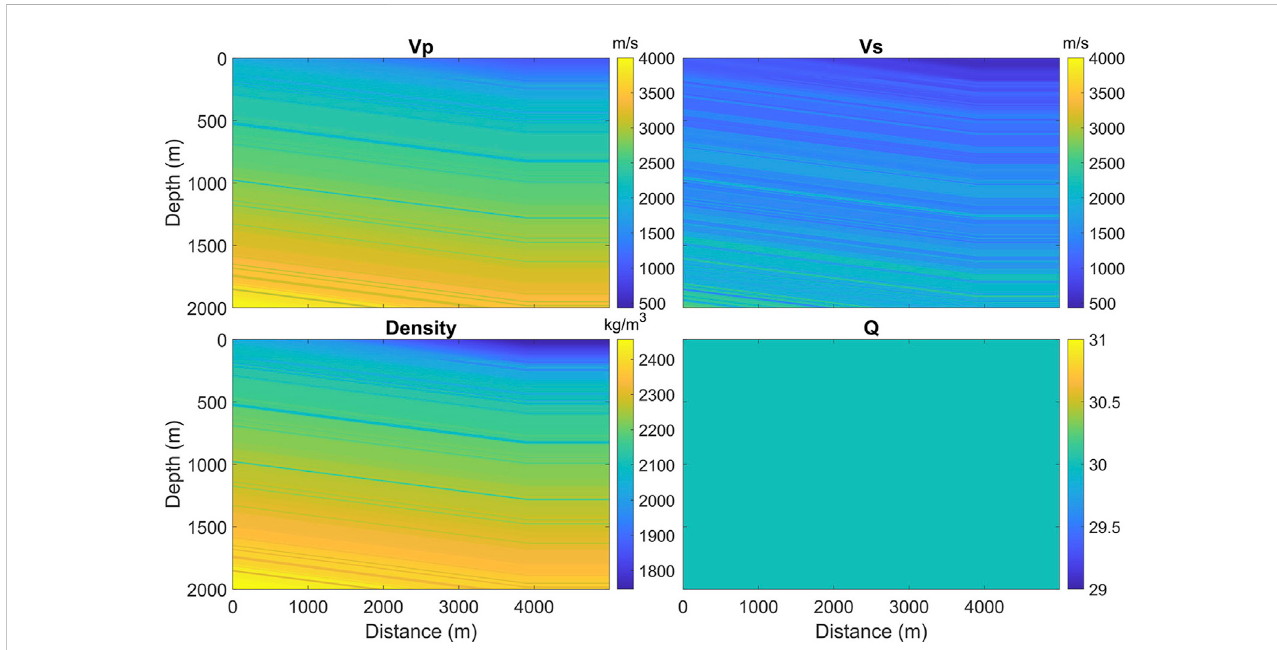
FIGURE 2 Models with randomized elastic properties for viscoelastic waveform modeling. Four properties are needed, including P-wave and S-wave velocities, density, and a seismic quality value that expresses energy attenuation in a media.